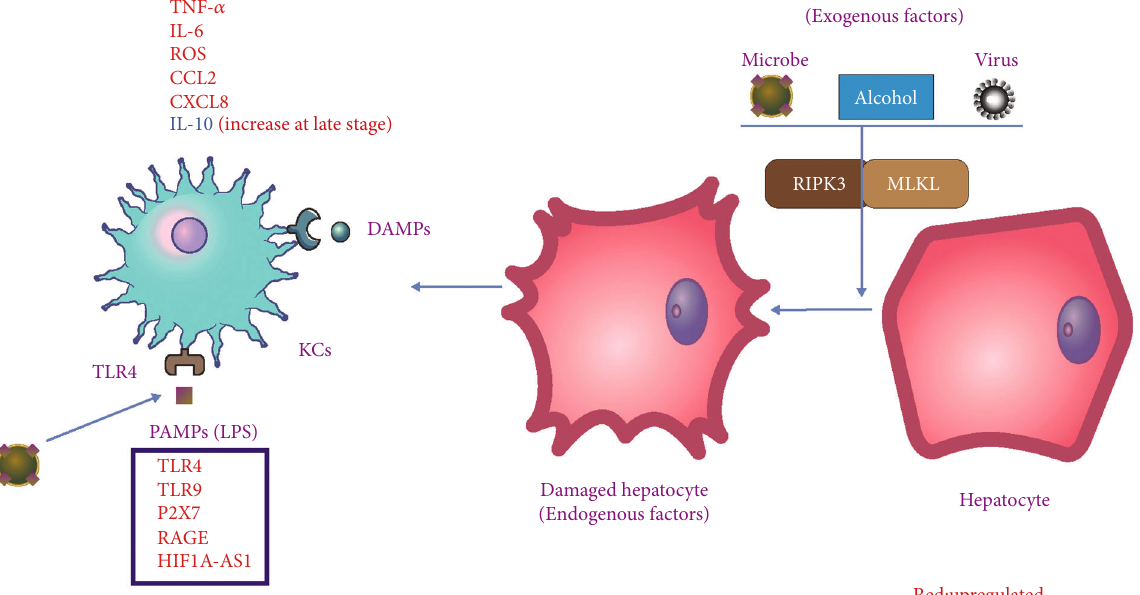
Figure 2: The initiation of hepatic in fl ammation. Bacteria, HBV, alcohol, and other external factors lead to hepatocyte necrosis through regulatory proteins such as RIPK3 and MLKL, and DAMPs produced by them are recognized by DAMP receptors such as TLR4, TLR9, P2X7, and RAGE expressed by macrophages/KCs. Or PAMPs produced by various pathogens, recognized by PRRs expressed by macrophages/KCs. Macrophages/KCs can secrete reactive oxygen species (ROS), proin fl ammatory cytokines, and chemokines; enhance in fl ammatory signals; and recruit other immune cells to the liver, speeding up the in fl ammatory process.